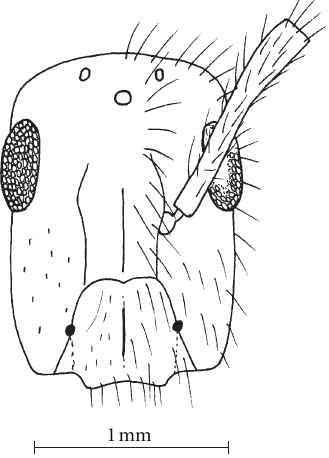
Figure 5: Head of the holotype female of C. reburrus .